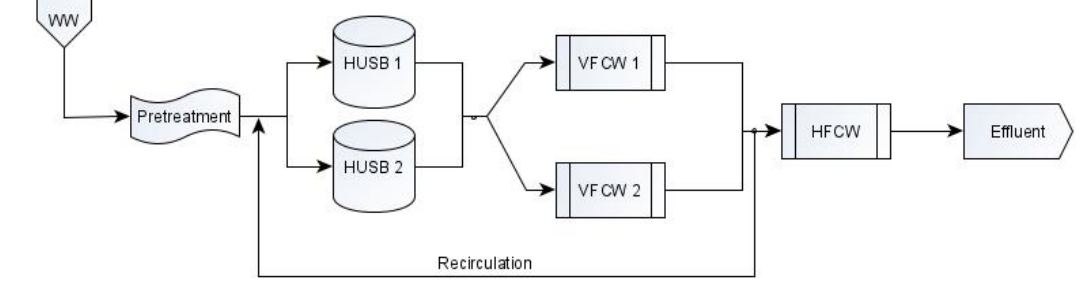
Figure 2. Diagram of the wastewater treatment system.